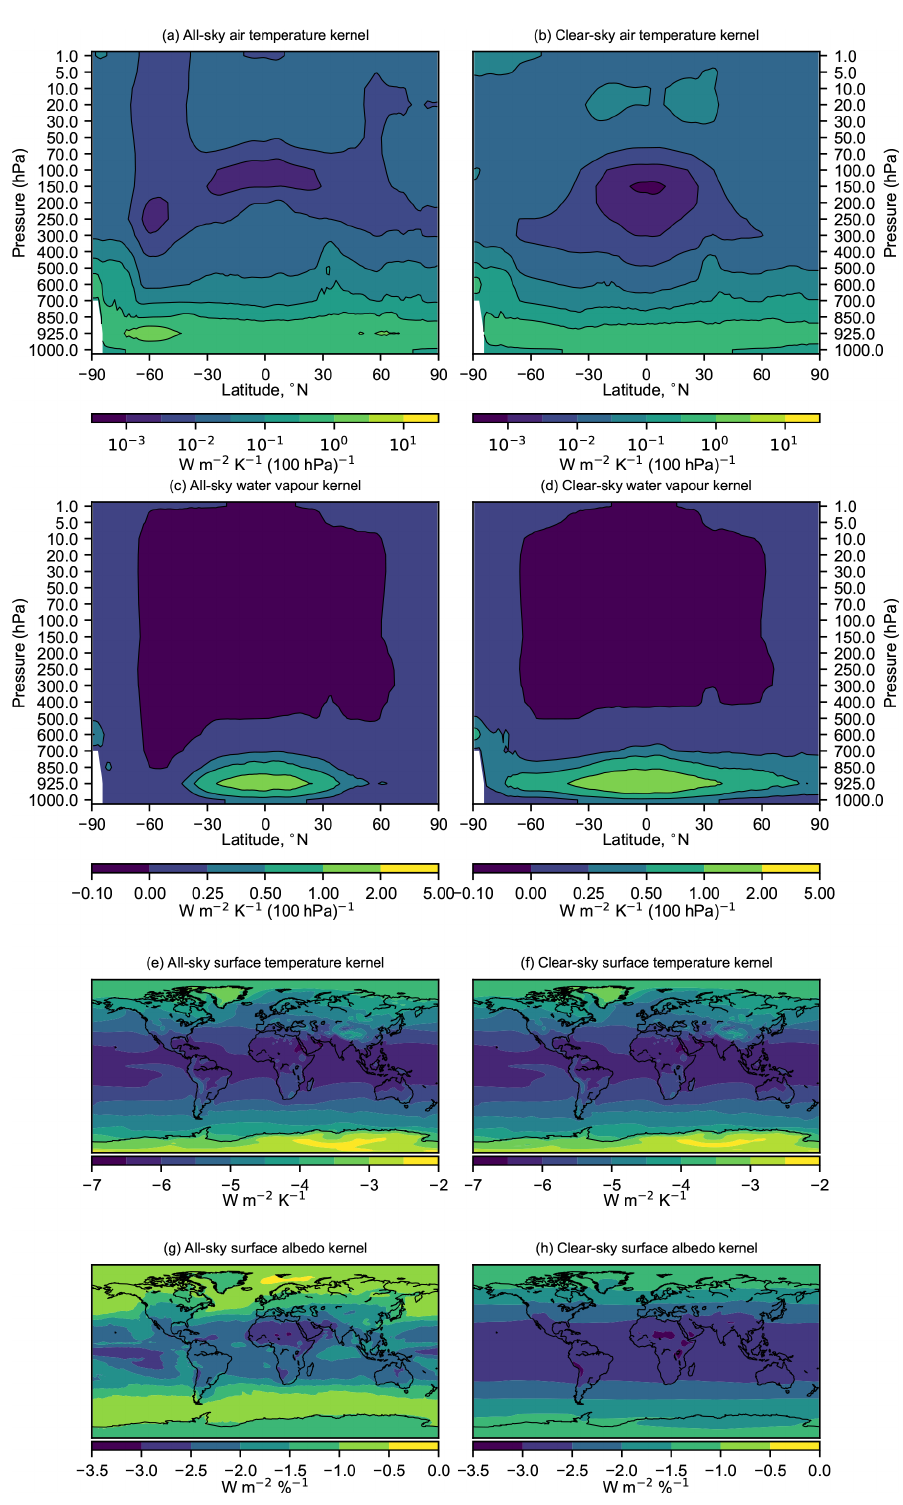
Figure 2. Surface radiative kernels from